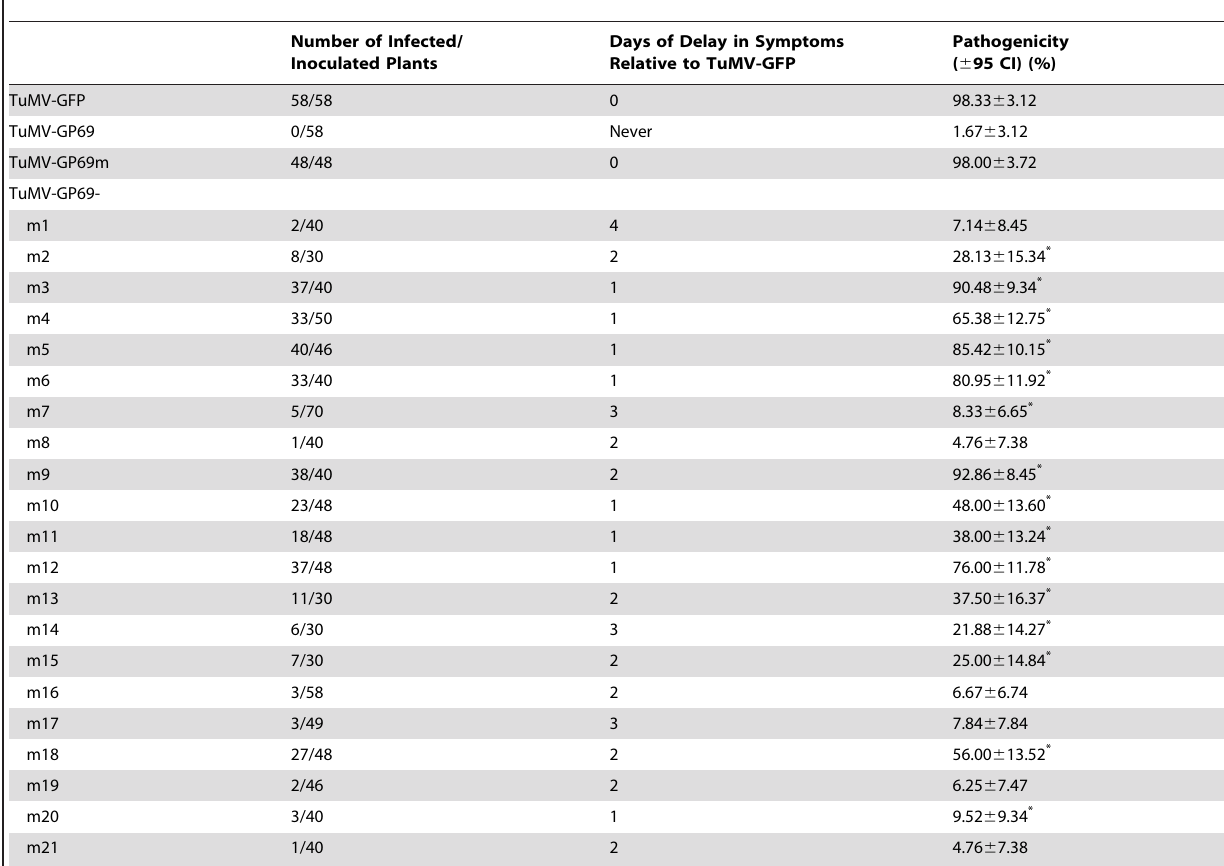
Table 1. Pathogenicity of -nt substitution of chimeric TuMV-GFP viruses on amiR 159 -P69